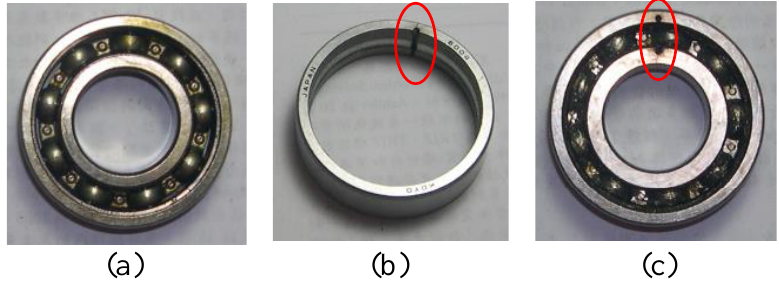
Figure 10. The bearing: ( a ) Healthy; ( b ) Outer raceway after damage; ( c ) Damaged bearing.